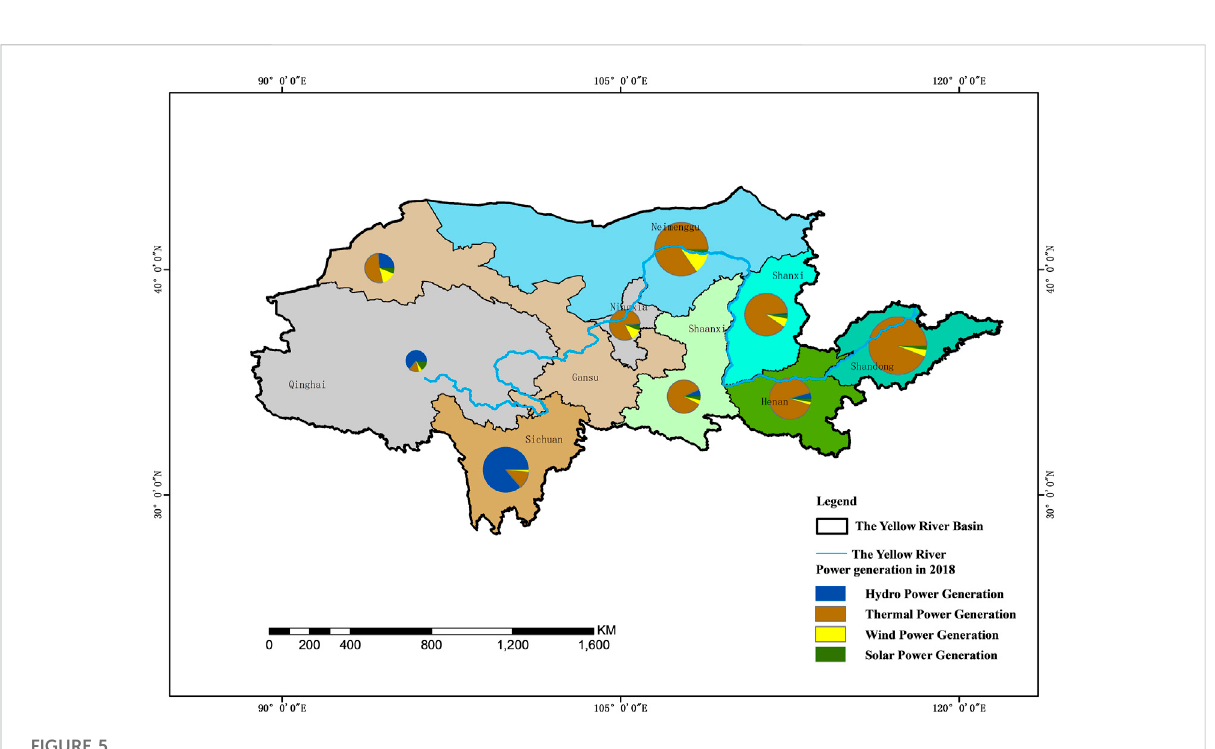
FIGURE 5 Energy structure of the Yellow River basin in